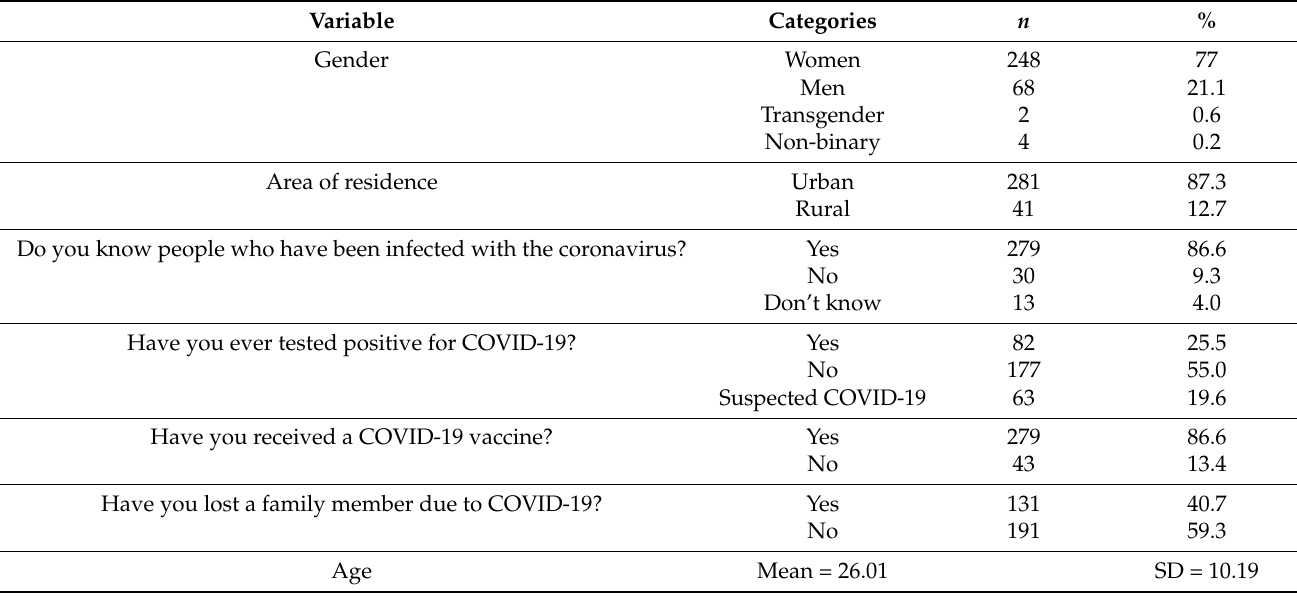
Table 1. Description of the study sample ( n =